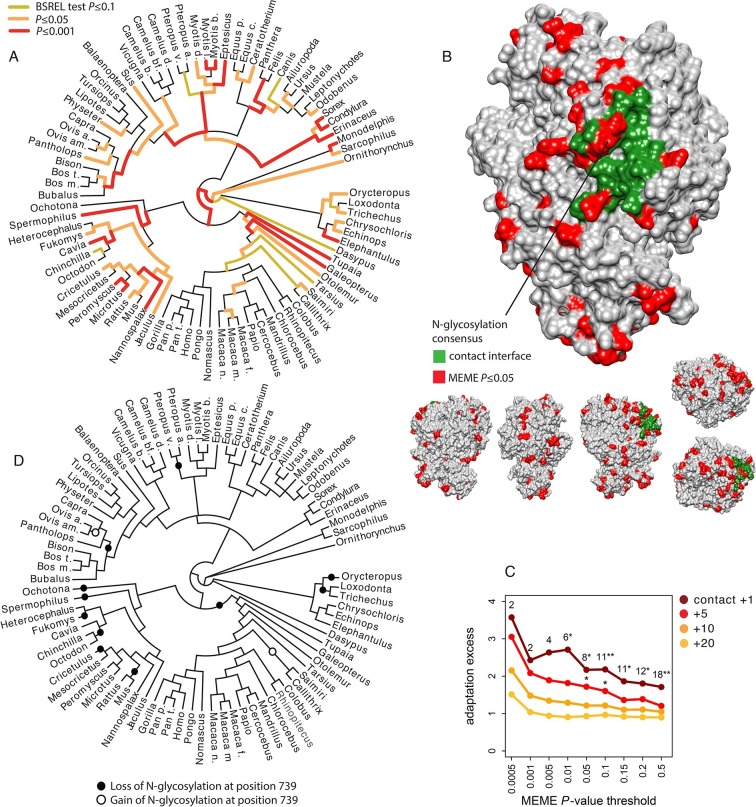
Patterns of adaptation to coronaviruses in aminopeptidase N.(A) BS-REL test results for ANPEP in a tree of 84 mammalian species. Legend is on the figure. (B) Contact surface with PRCV and TGEV on ANPEP structure (PDB 4FYQ). The figure includes visualizations of all the six different faces of ANPEP. Legend is in the figure. (C) Excess of adaptation in and near the contact interface with PRCV and TGEV. Within the contact interface plus a given number of neighboring amino acids (one, five, ten or 20 in the figure), adaptation excess (y axis) is defined as the number of observed codons with a MEME P-value lower than the P-value threshold on the x axis, divided by the average number of codons under the same P-value threshold obtained after randomizing the location of adaptation signals over the entire ANPEP coding sequence 5000 times. Dark red curve: adaptation excess within the contact interface with TGEV and PRCV plus one neighboring amino acid. Red curve: plus five neighboring amino acids. Orange: plus ten neighboring amino acids. Light orange: plus 20 neighboring amino acids. Numbers in the figure represent the number of adapting codons, and the stars give the significance of the excess. One star: excess p≤0.05. Two stars: p≤0.01. (D) Losses and gains of the N-glycosylation across the mammalian phylogeny.